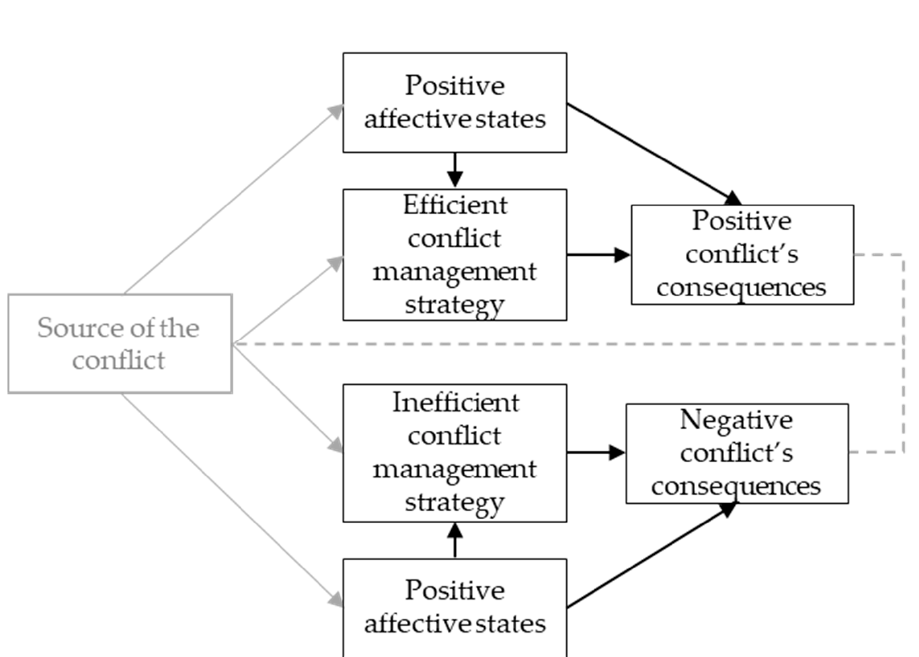
Figure 4. Visual representation of relationships revealed by the model. Note: black color denotes hypothesized relationships supported by the data; gray color denotes hypothesized relationships not supported by the data.